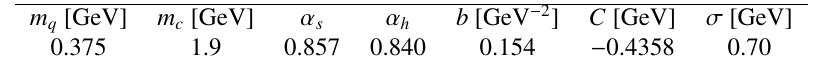
Table 1. Parameters of the quark Hamiltonian determined to reproduce the meson masses in [16, 17]. The charm quark mass m c is also determined to fit the charmed meson masses